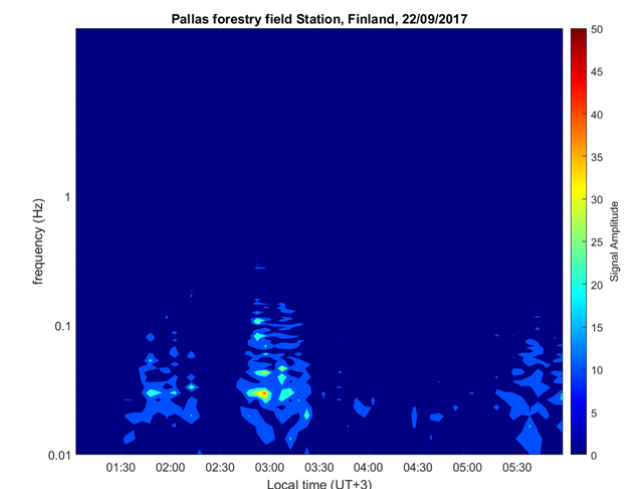
Figure 4. A spectrogram of infrasound data from the INFRA20 sensor placed in Pallas, Finland, on 22 September 2019. (On the x axis is local time in hours; on the y axis is the frequency of the infrasound signals. The colour bar on the right shows the strength of the infrasound signals.).